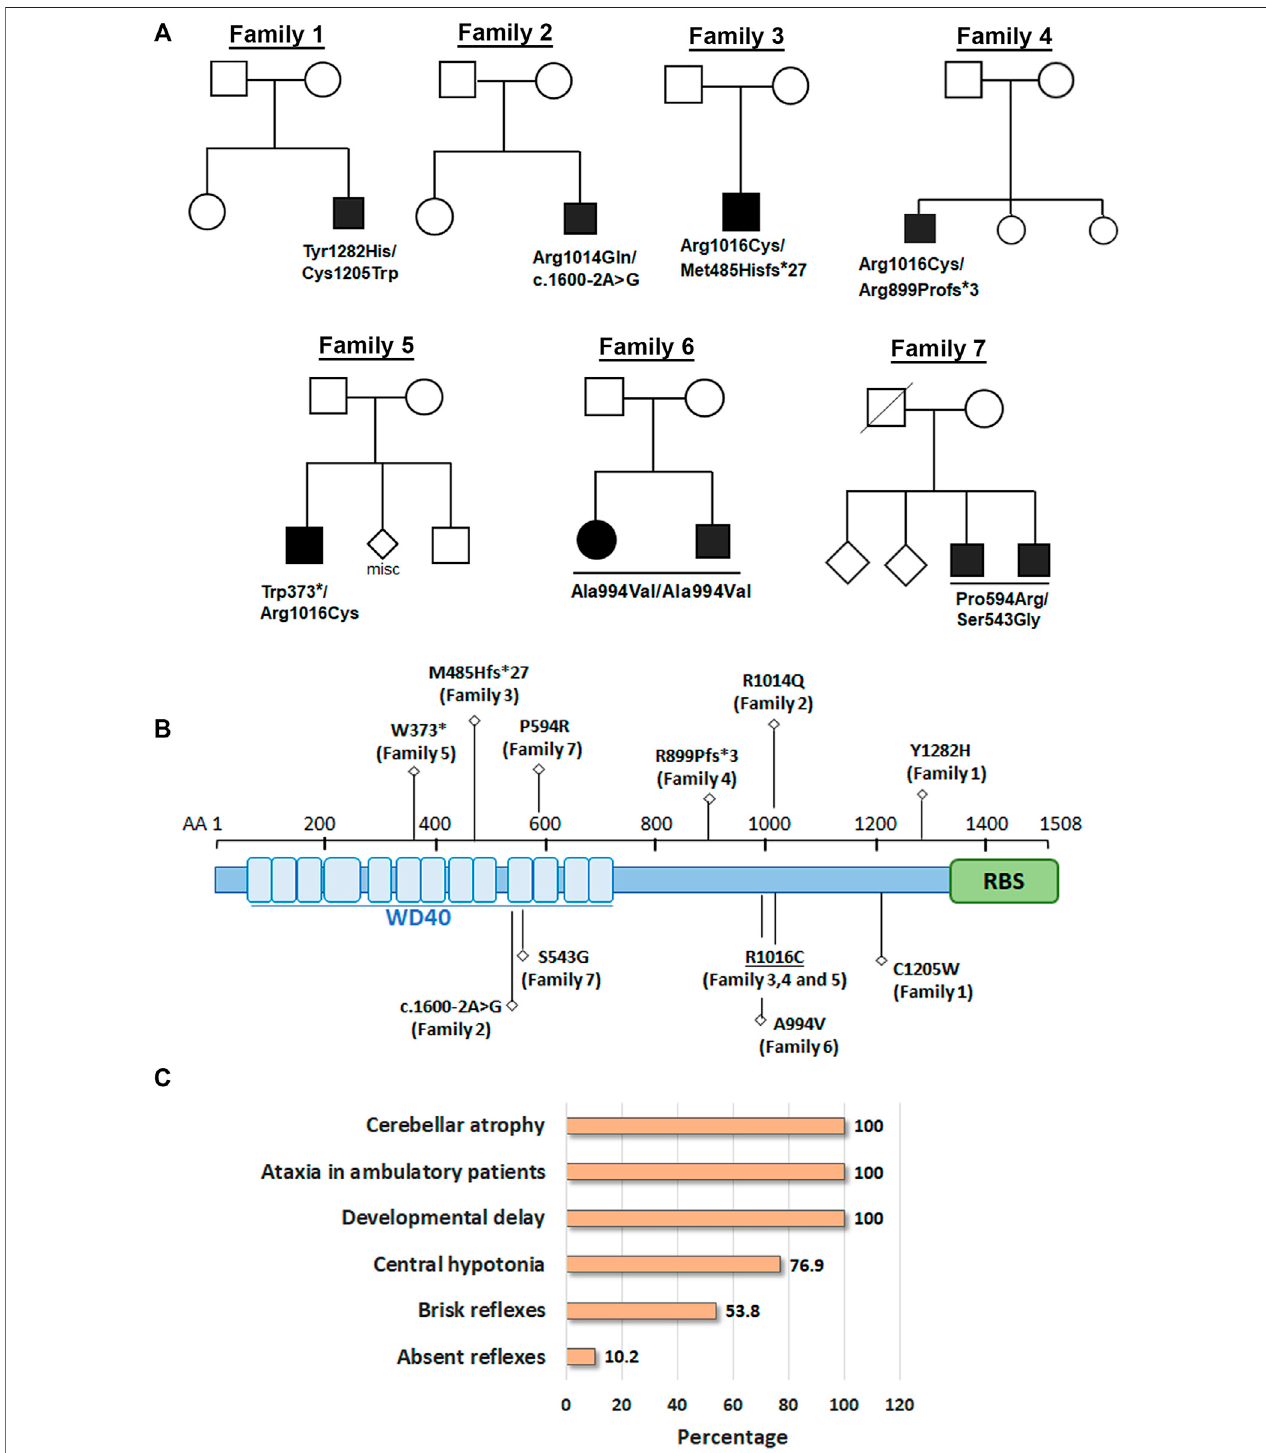
FIGURE 1 | Biallelic variants in GEMIN5 leads to cerebellar atrophy and spastic ataxia neurodevelopmental disease. (A) Pedigrees of seven unrelated families with nine affected individuals are shown in the top panel. Variants in GEMIN5 are shown below the affected individuals. Affected individuals are shown as fi lled black circles/ squires. (B) GEMIN5 protein domain structure. Type and position of the identi fi ed variants are shown along with the family numbers. (C) The frequency of clinical presentations in our patients with autosomal recessive variants in GEMIN5 . The numerator and denominator in brackets indicate the number ofaffected probands and the number of probands assessed for the respective feature, respectively.